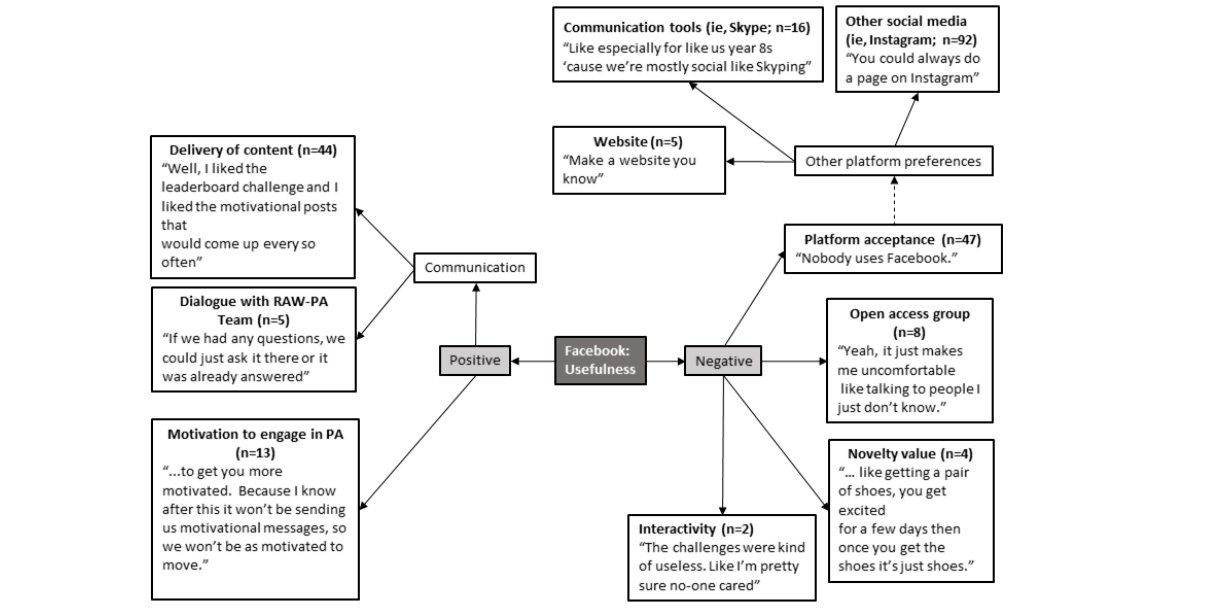
Figure 6. Perceived usefulness of Facebook in adolescents. PA: physical activity; RAW-PA: Raising Awareness of Physical Activity. Note: n=number of times theme was mentioned by adolescents; --- indicates an extension of a theme.